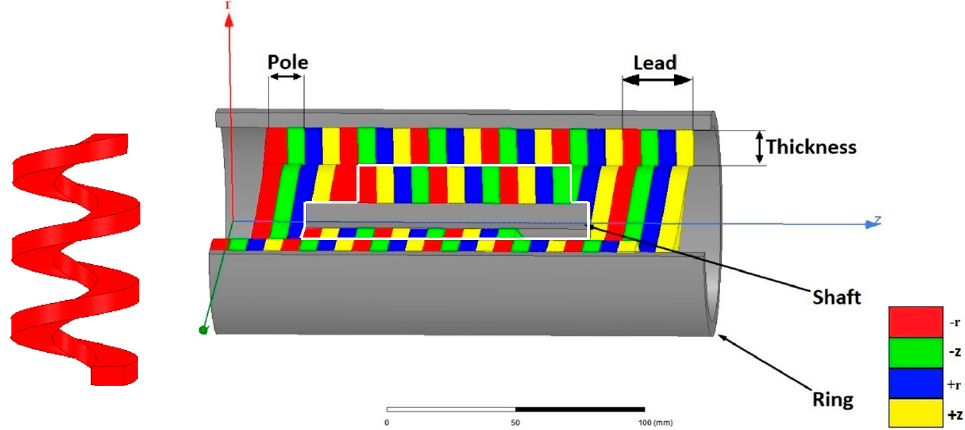
Figure 2. The segmented magnetic array shaft and ring framework: highlighting the helical nature of magnetic arrangement (3D representation). magnetic arrangement (3D